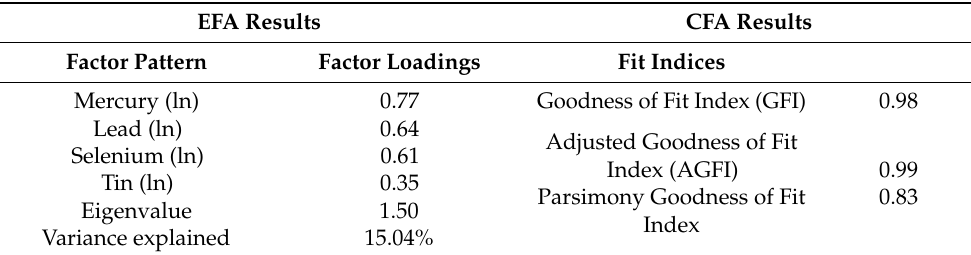
Table 1. Exploratory (n = 192) and confirmatory (n = 192) factor